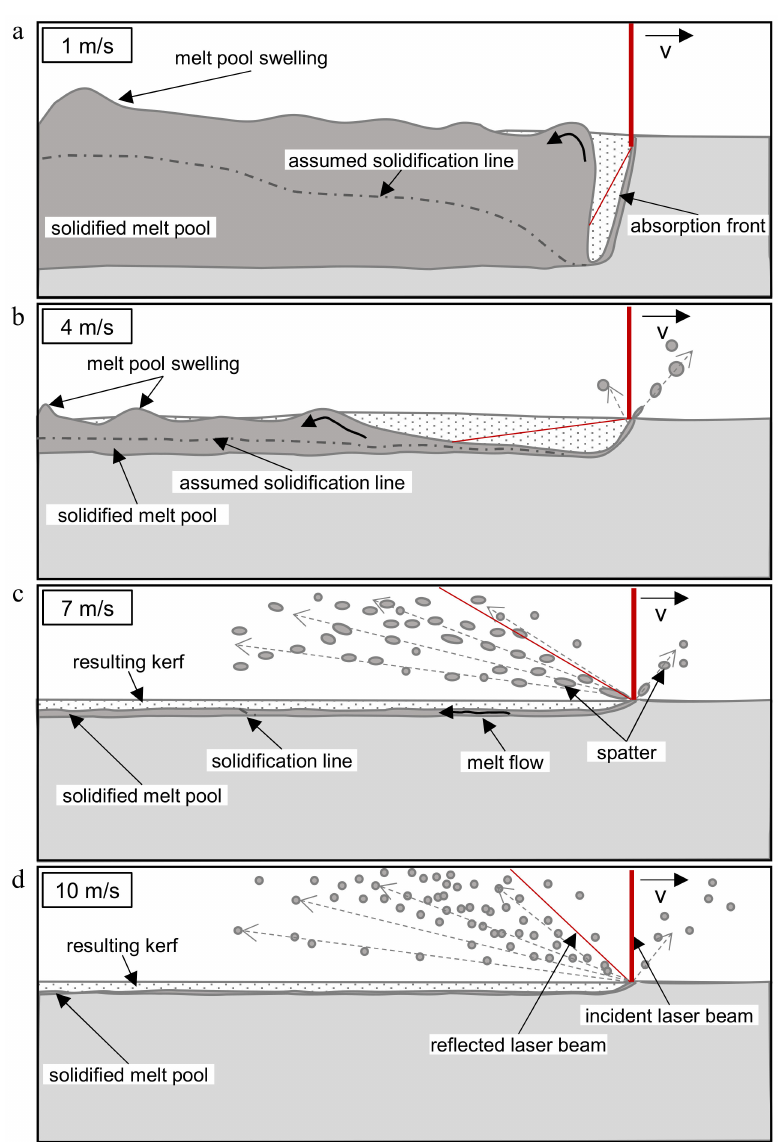
Figure 11. Empirical process models for ( a ) 1 m/s, ( b ) 4 m/s, ( c ) 7 m/s, and ( d ) 10